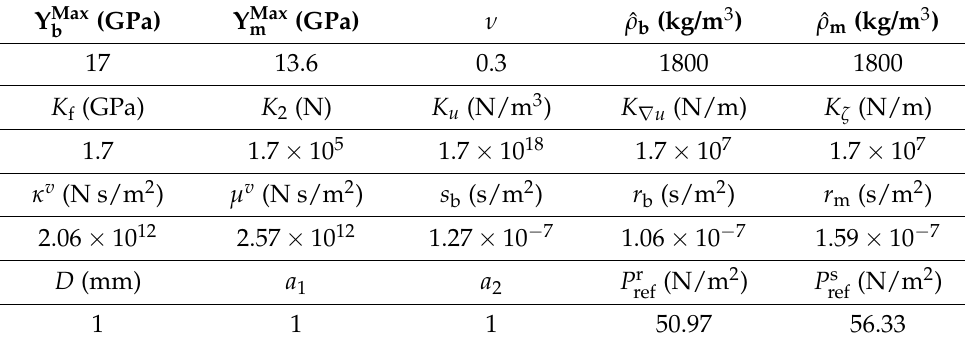
Table 1. Material parameters used in the numerical